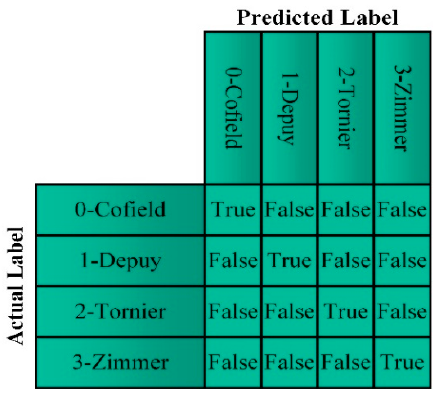
Figure 5. Confusion matrix.